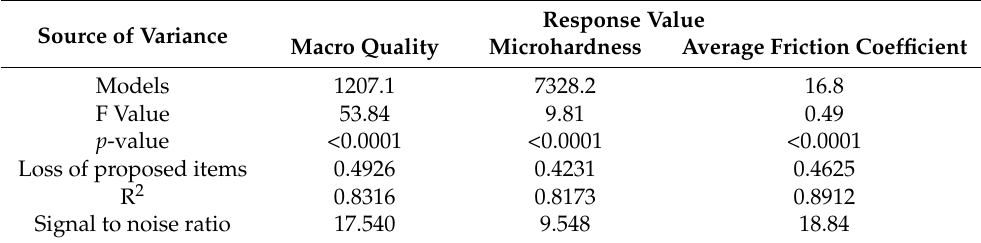
Table 3. Analysis of variance of response